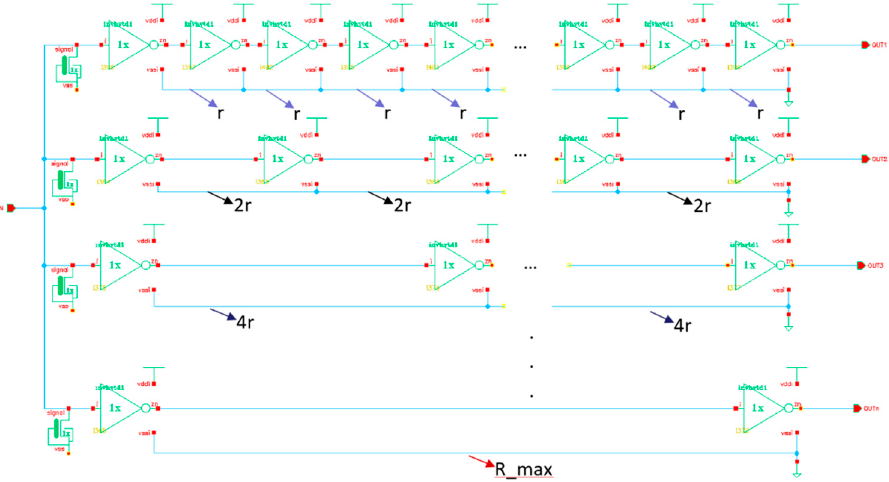
Figure 4. CDM module structure and principle: each row will double the length of the ground wire. The module’s lowest ground resistance value was noted “r” and the module’s highest ground re ‐ sistance value is noted R_max~2 11 × r.